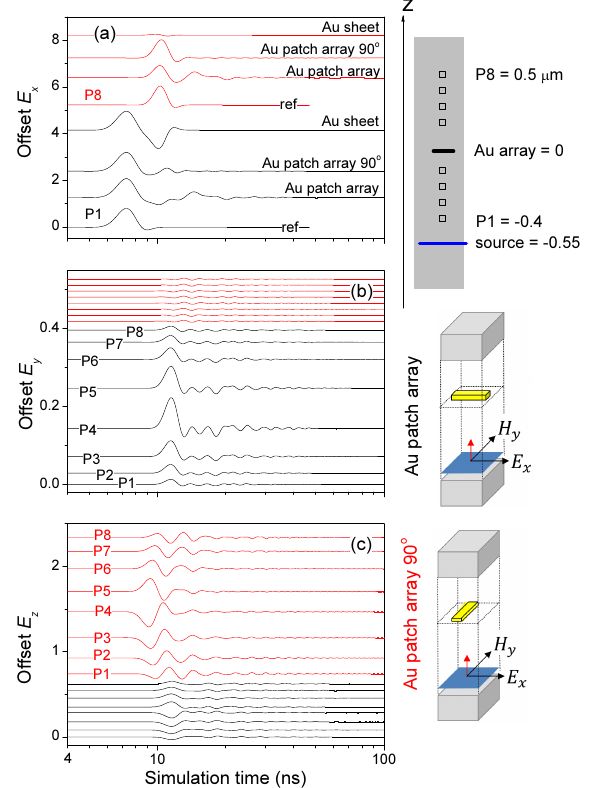
Figure 3. Temporal developments of the electric field components ( a ) E x detected at P1 (black lines) and P8 (red lines), ( b ) E y and ( c ) E z at the 8 probes (P1, P2, . . ., P8) under ( E x , H y ) polarization through different microstructures, simulated by